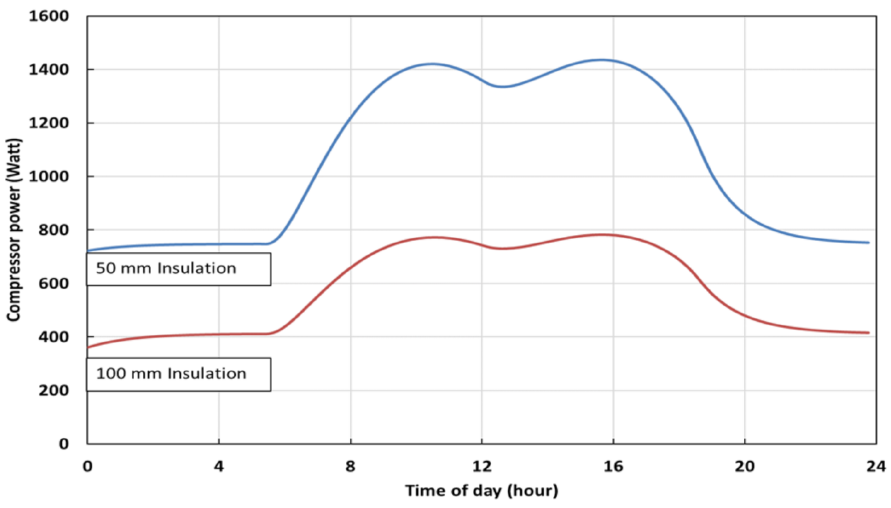
Figure 12. Required compressor thermal power for insulation materials 50 mm thick and 100 mm thick in summer with a shaded